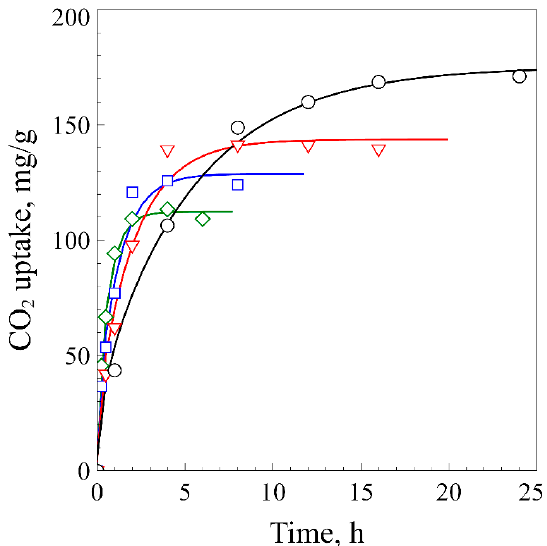
Figure 2. The CO 2 sorption kinetics of ABS/R-PET at 10 MPa and the temperature of − 20 °C (Circle), 0 °C (Triangle), 20 °C (Square), and 40 °C (Diamond). The experimental data were fitted to Equation (2). The amount of CO 2 absorbed in the blend increased as the saturation temperature decreased, whereas the time to reach the saturation became longer. Table 1. The saturation concentrations (Csat) and diffusion coefficients (D) of CO 2 in ABS/R-PET blend.